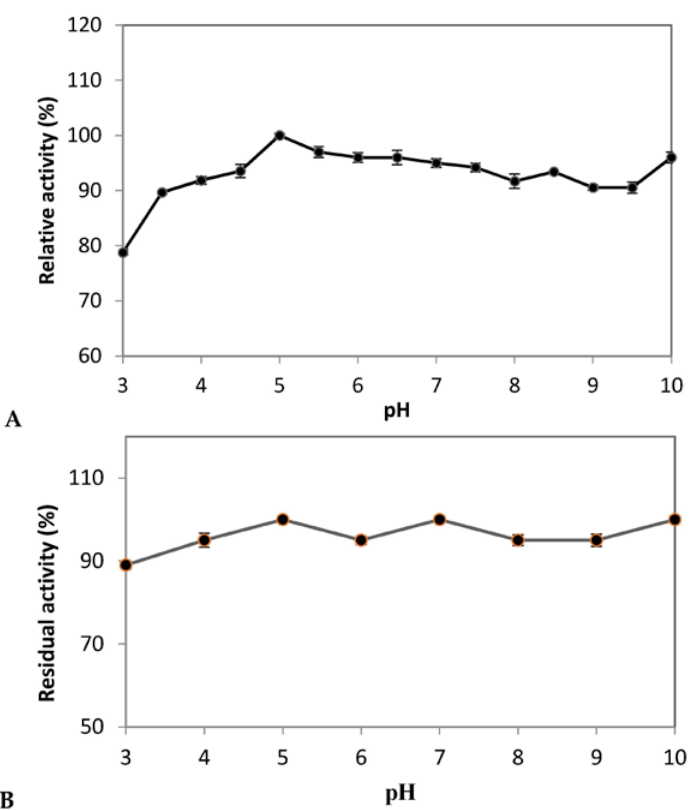
Figure 4. Effect of pH on the activity ( A ) and stability ( B ) of PG of A. pullulans isolated strain. Each point represents the mean ( n = 3) ± standard deviation.